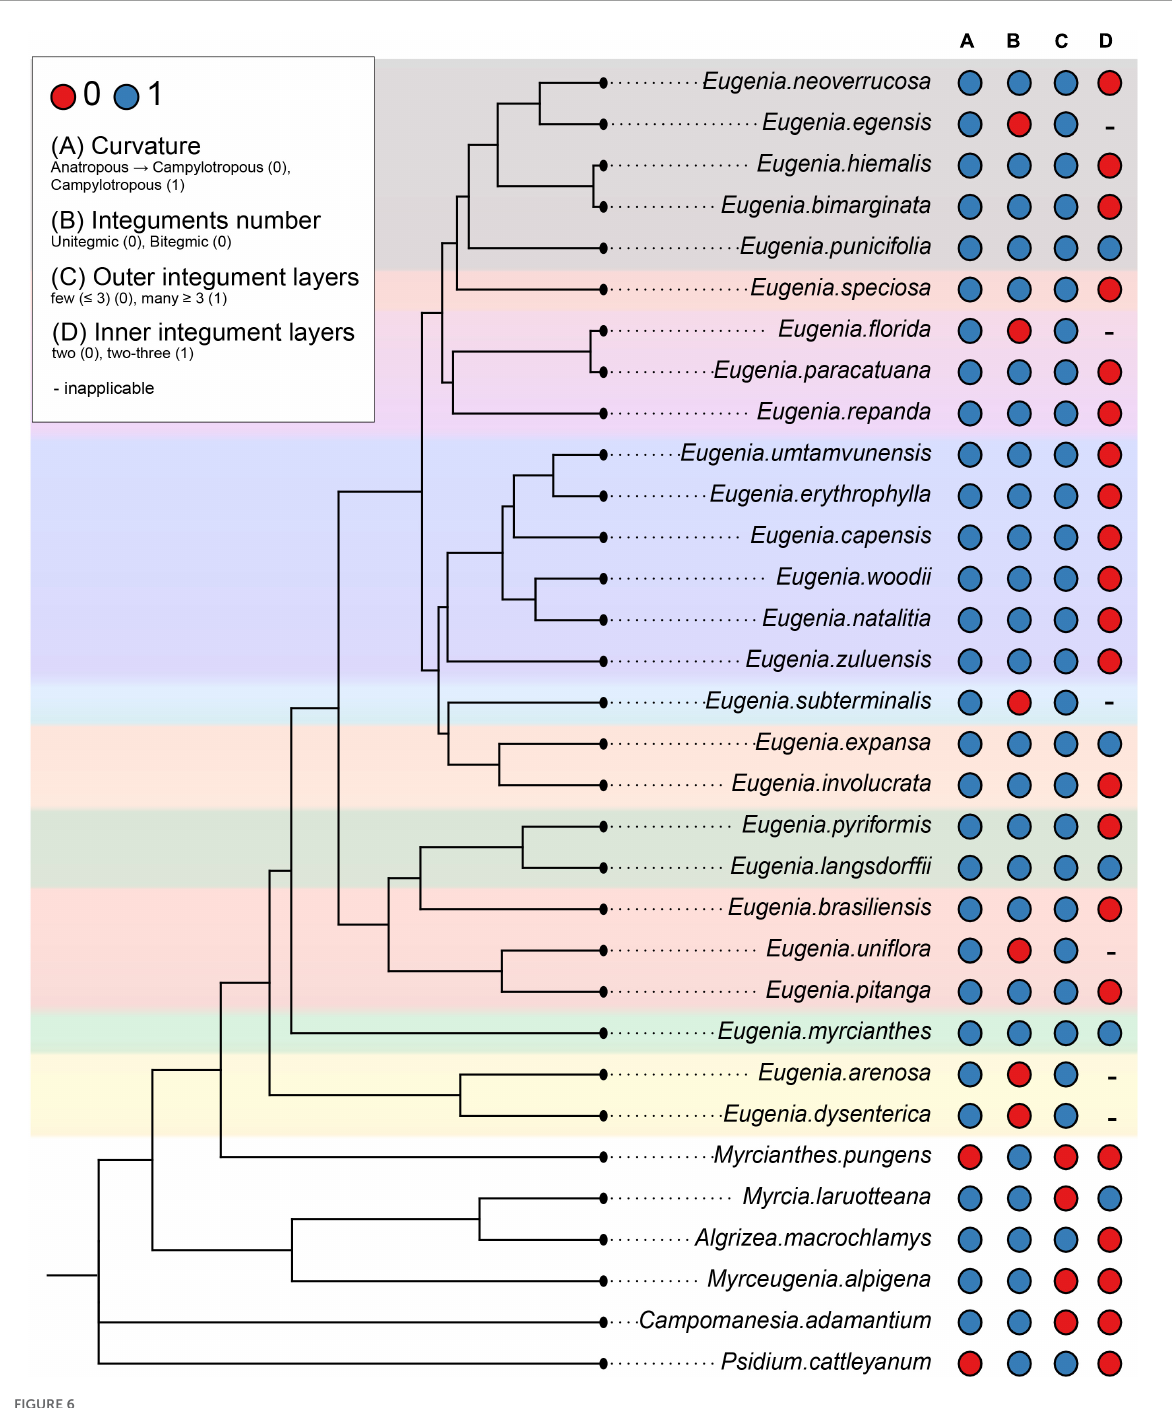
between states on average; lignified endotesta arose on more than one linage independently within Eugenia ( Supplementary Figure 11